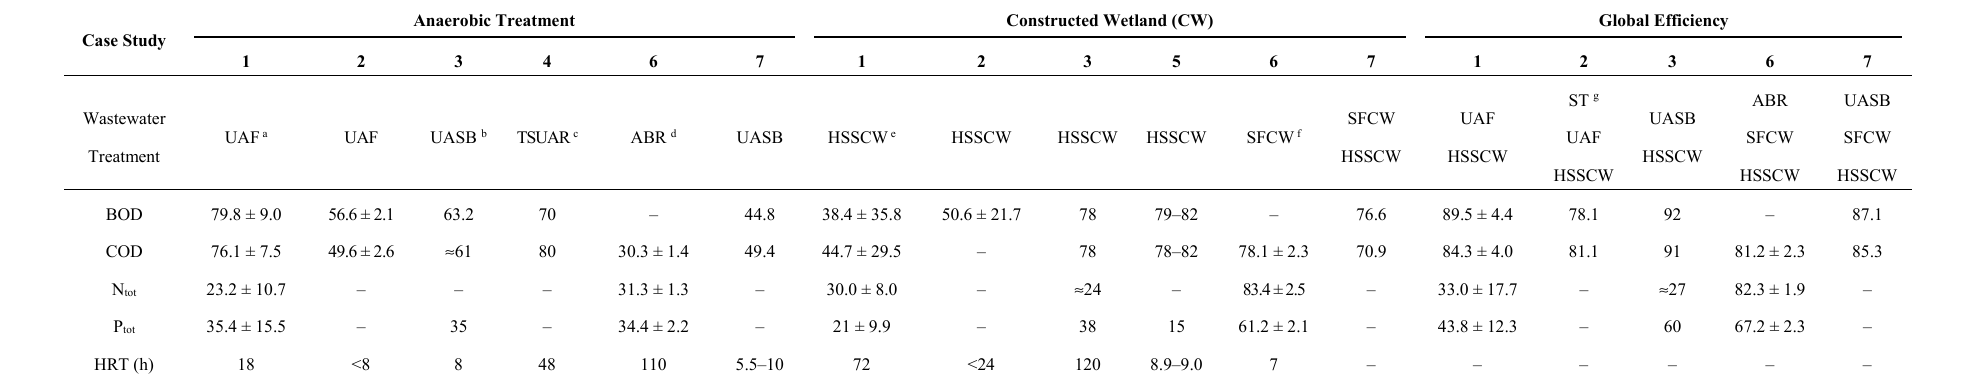
Table 3. Pollutant removal efficiency comparison